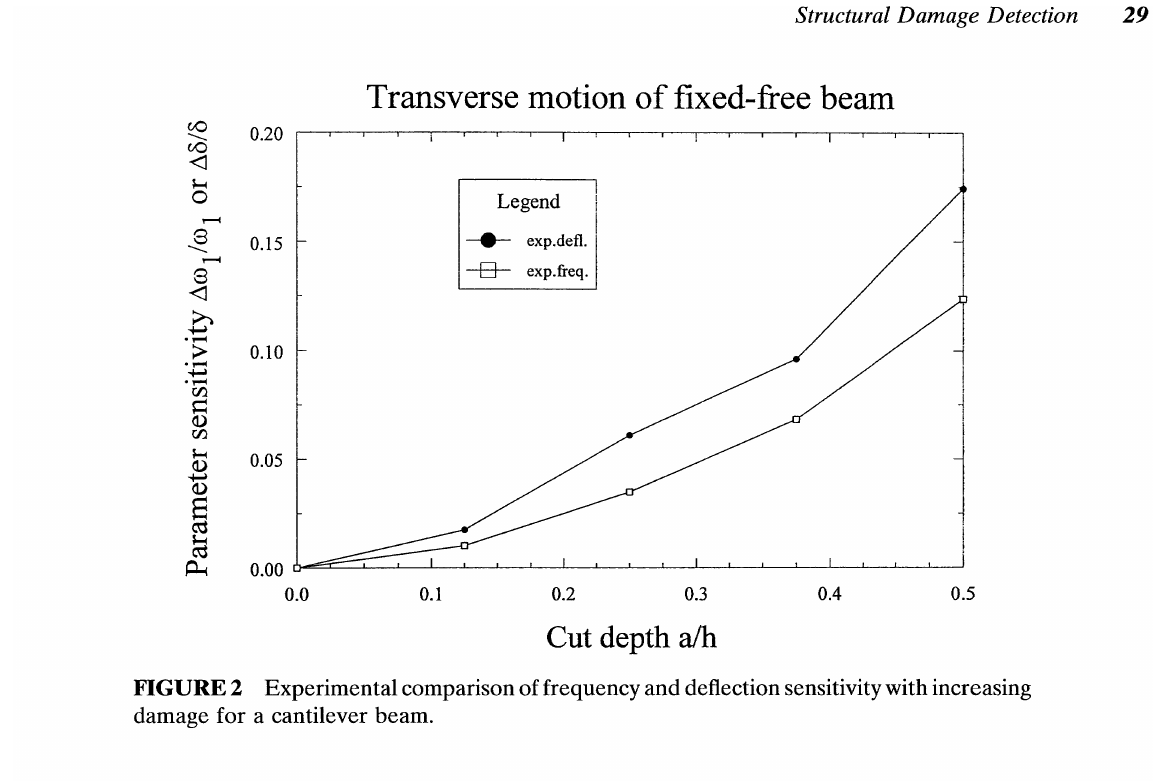
FIGURE 2 Experimental comparison of frequency and deflection sensitivity with increasing damage for a cantilever beam.